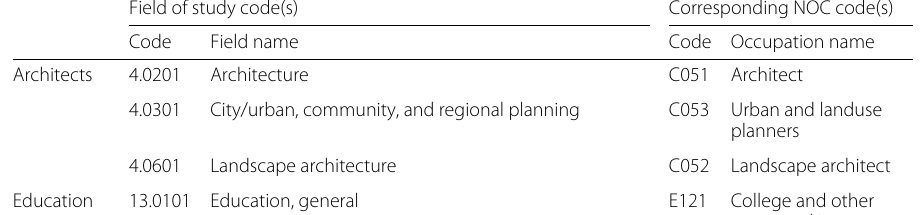
Table 16 Specialized occupation and field of study matches Field of study